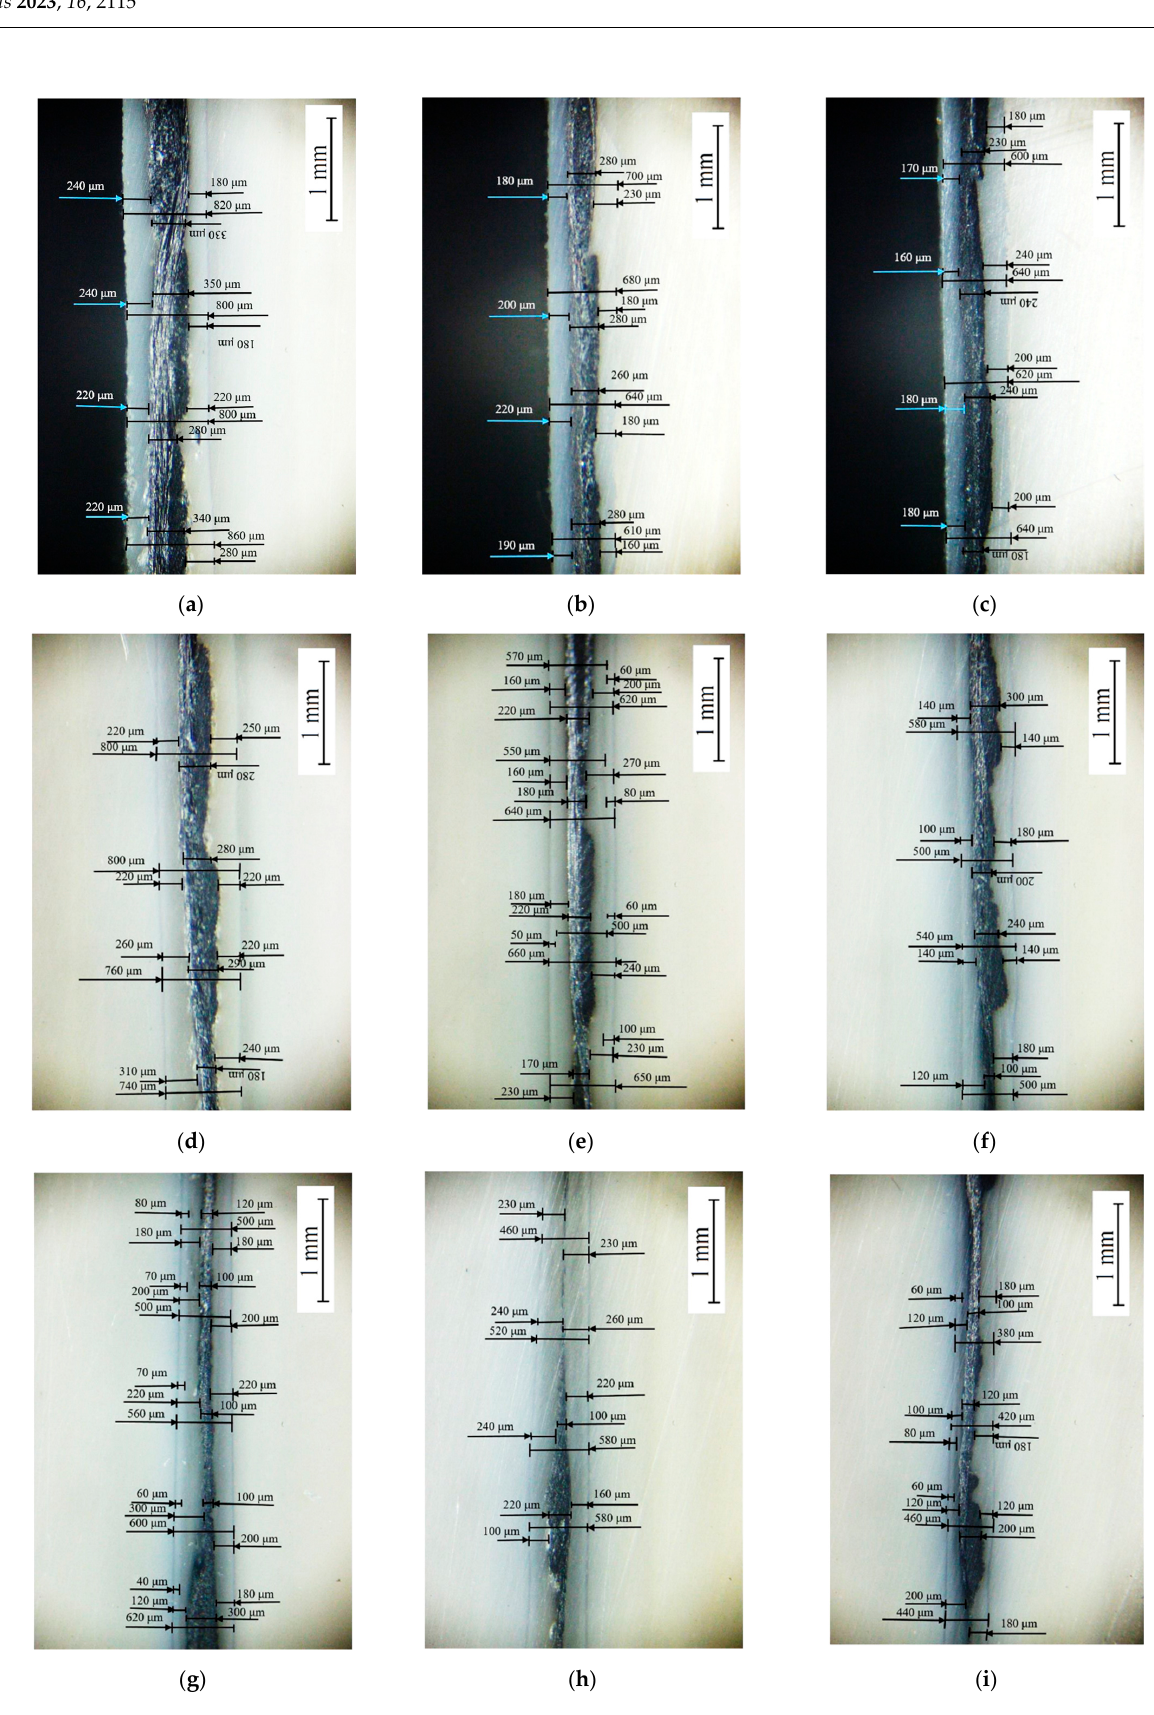
Figure 6. General-view photos of the fractured USW lap joints after the tensile tests (( a – i ), for modes 1–9, respectively).